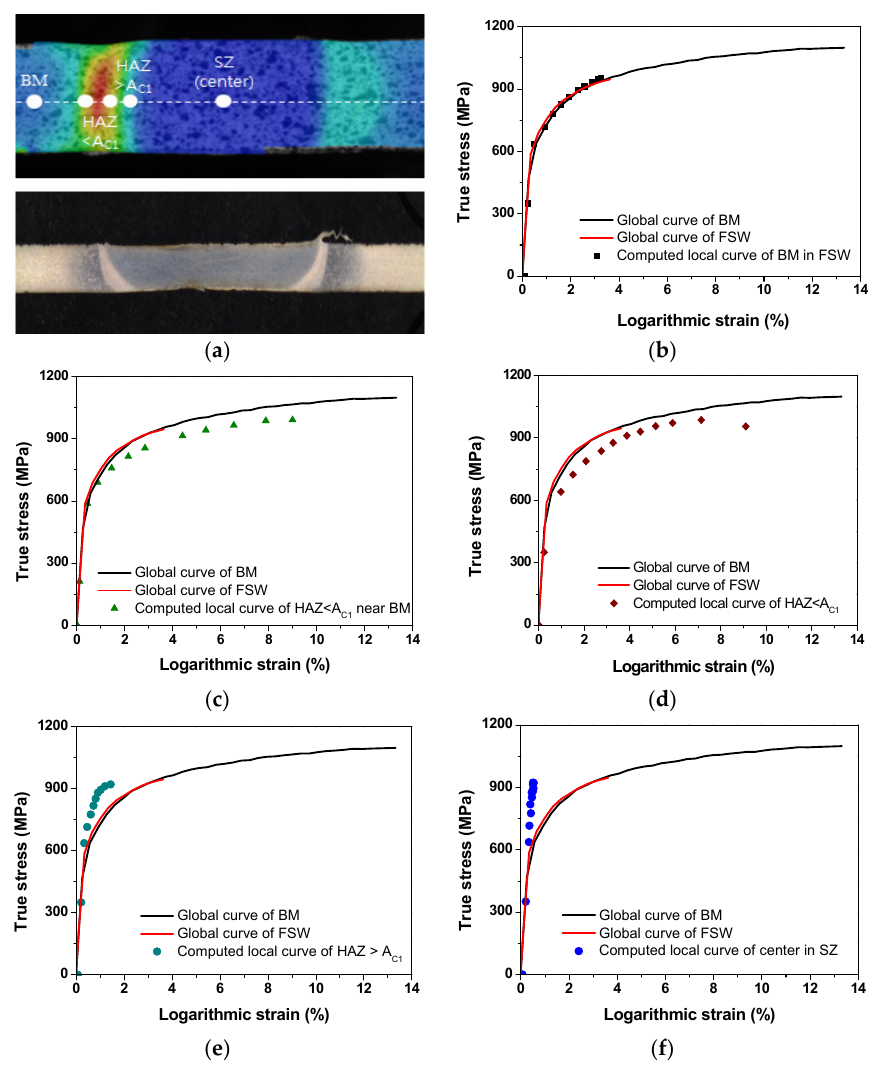
Figure 11. Local stress ‐ strain curves computed by digital image correlation (DIC) for specific microstructural regions: ( a ) measuring points; ( b ) at BM; ( c ) at HAZ < Ac 1 near BM; ( d ) at HAZ < Ac 1 near boundary; ( e ) at TMAX/HAZ < Ac 1 ; ( f ) at center of SZ. Materials 2015 , 8 , page–page